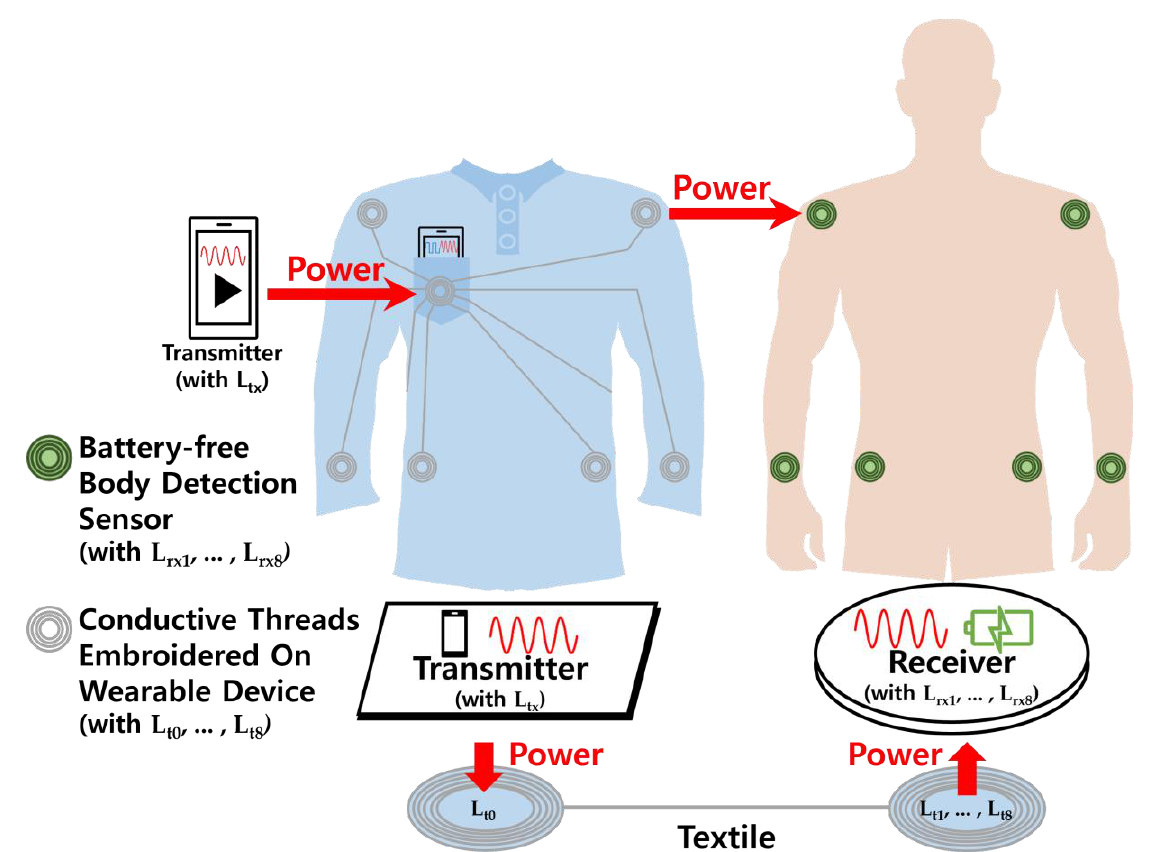
Figure 1. A wireless power supply system consisting of TX, the textile embroidered with induction patterns made of wires, and RX (sensor).